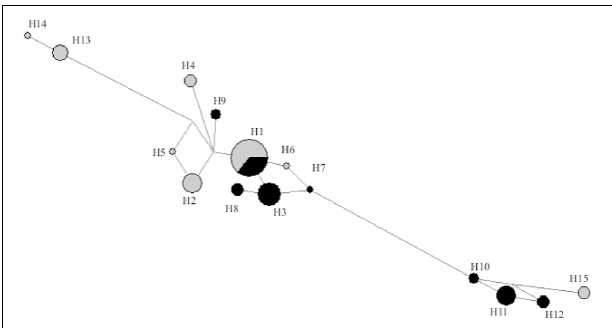
FIGURE 2 | Phylogenetic network for the H. carunculata populations studied. Haplotypes from individuals from Alykes are represented with gray color, those from Elounda with black. Circle size is proportionate to the frequency of the haplotypes and the distances proportional to the number of the evolution steps. H: